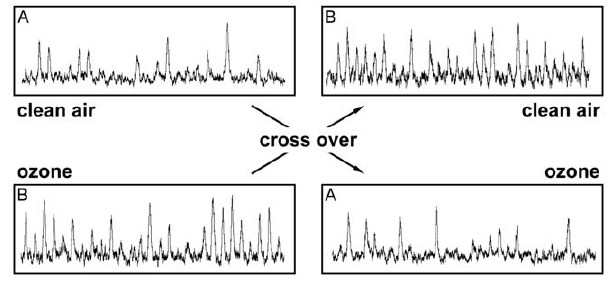
Figure 1. Examples of integrated muscle sympathetic nerve activity recorded at about 19–22 hours after exposure to clean air or to ozone in two subjects. doi:10.1371/journal.pone.0018737.g001 PLoS ONE |